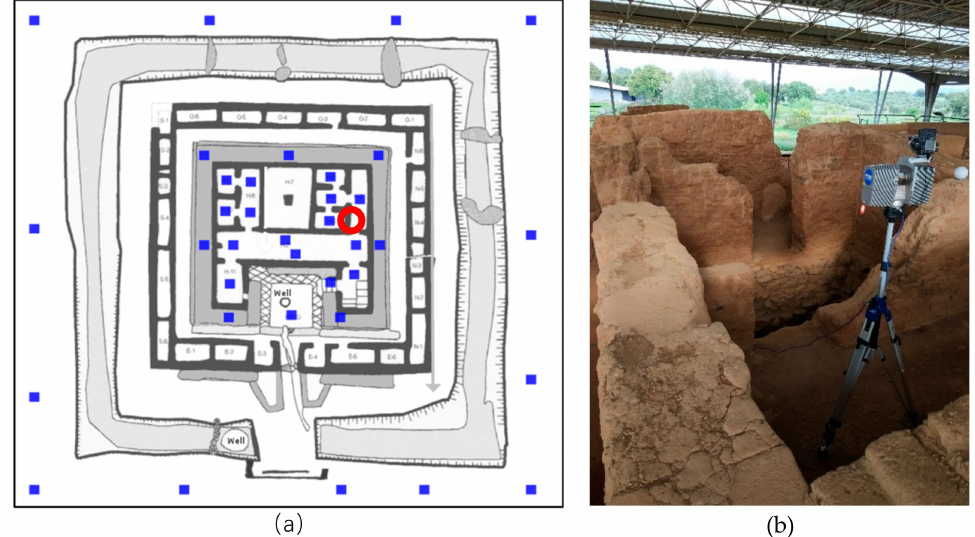
Figure 3. ( a ) Cancho Roano site map with the scanner positions indicated by blue squares. ( b ) The Faro LS-880 is placed in the position marked with the red circle in ( a